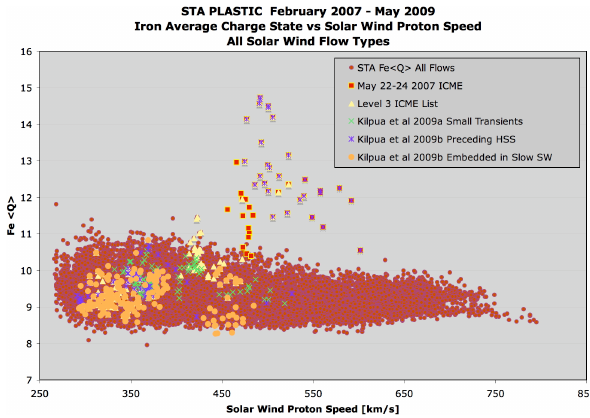
Fig. 4. During November 2007, coronal hole-associated streams, slow solar wind, and an ICME were observed by STEREO A (STA). Solar wind iron average charge states observed by The black trace is the solar wind proton speed, while the brown- STEREO A (STA) compared against solar wind speeds covering orange trace is the iron average charge state. The orange portion 27.5 months from 14 February 2007 through 31 May 2009. Each of the Fe < Q > trace corresponds to the ICME interval identified data point (brown circles) represents an hour sampling interval. by Jian (2009). This interval stands out compared to the Fe < Q > Also shown are time periods identified by various sources (Jian, for other flow types (CH or slow) during this particular month, but 2009; Kilpua et al., 2009a, b) as transient or ICME intervals. (There not when compared to overall averages for the entire survey. The is overlap among some of the identified transient periods, for exam- figure shows markers for the solar wind stream interfaces as de- ple as seen in the 22-24 May 2007 intervals.) termined using the entropy criteria described by Simunac (2009). The green arrowheads mark stream interfaces with an increase in entropy (nominally the “slow to fast” or SIR transition, although in case 3 it is also for the slow/ICME to CH transition), while the yellow arrowheads mark the drop in entropy (nominally the “fast to slow” solar wind transition). Shown near the top as blue arrows are the reverse and forward shocks identified by Jian